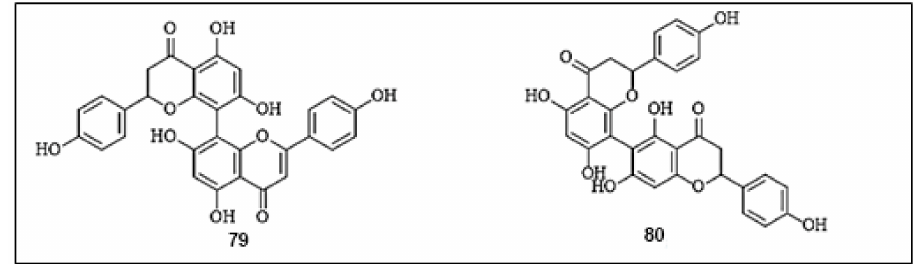
Figure 9. The chemical structures of biflavonoids with anti-tyrosinase activity. ( 79 ) Rhusflavanone; ( 80 ) Mesuaferrone B.